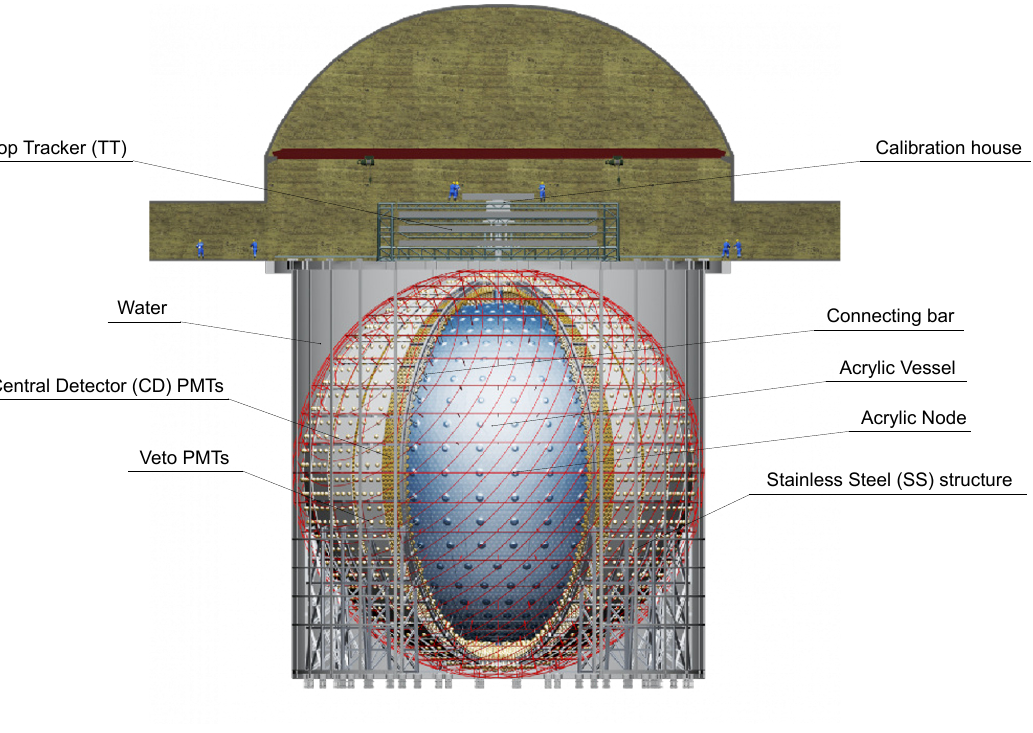
Figure 1. Schematic drawing of the JUNO detector showing the main components of the experi- mental